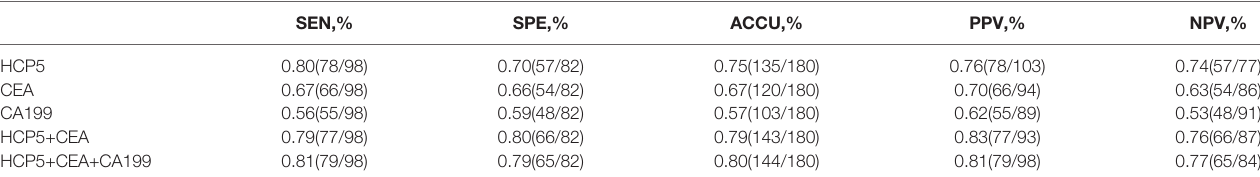
TABLE 2 | Combination of serum HCP5, CEA and CA199 levels signi fi cantly improves the diagnostic sensitivity between GC patients and healthy donors.